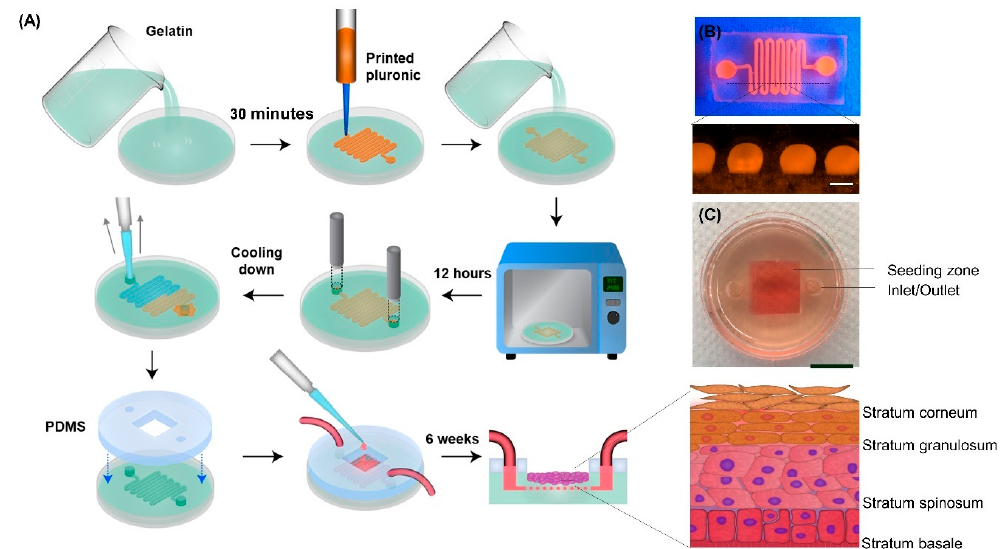
Figure 2. Model development and fabrication process. ( A ) Gelatin / transglutaminase (TG) solution was poured into a 35 mm petri dish. After partial gelation, 38% pluronic F127 solution was printed on the gelatin layer. Subsequently, another layer of TG / gelatin solution was poured on the printed pattern and the hydrogel was incubated at 37 ◦ C for 12 h. After punching an inlet and outlet, the hydrogel was cooled down and the liquid pluronic was removed from channel. Finally, a sterilized polydimethylsiloxane (PDMS) mold was mounted on the gelatin. After 6 weeks culture at the air-liquid-interface, immortalized human keratinocytes (HaCaT) cells formed a multilayer structure. ( B ) Cross-sectional view of the channel embedded in gelatin hydrogel. Scale bar is 500 µm. ( C ) Overview of the final model for submerged culture. Scale bar is 1 cm.